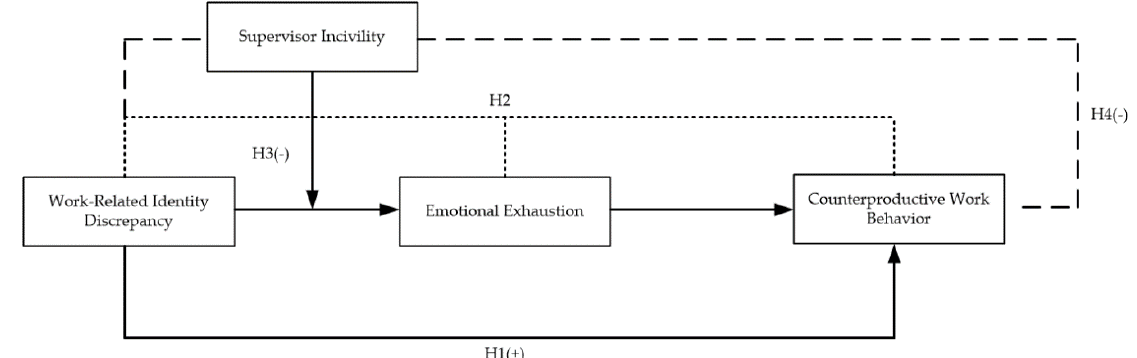
Figure 1. The research conceptual model.